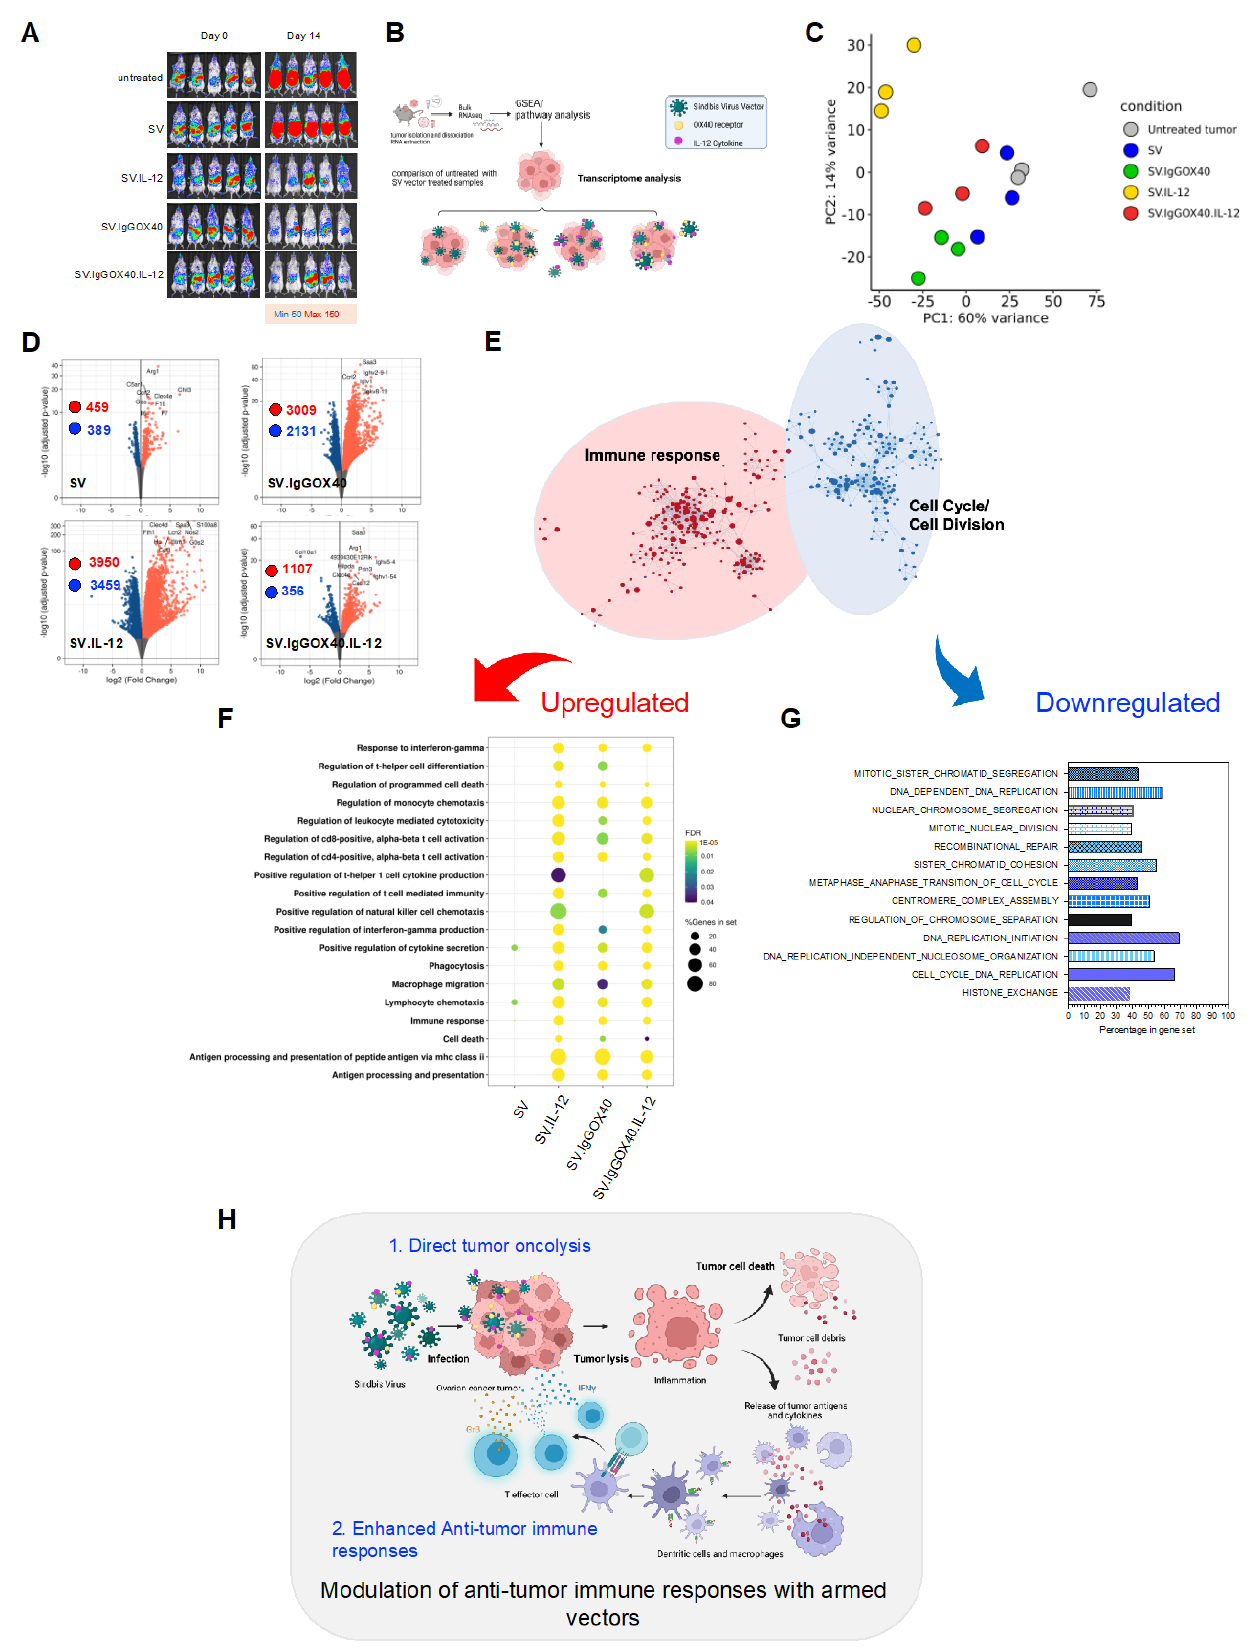
Figure 9. Sindbis virus vector therapy remodels tumor transcriptomes in tumor-bearing mice. Potent and targeted anti-tumor SV therapy in vivo for ovarian cancer. Sindbis virus vector therapy remodels tumor transcriptome in tumor-bearing mice. We performed RNAseq to evaluate SV-ther- apy-dependent inhibition of tumor growth in tumor-bearing mice within the first 2 weeks of treat- ment. We characterized functional changes in gene expression with regards to treatments using